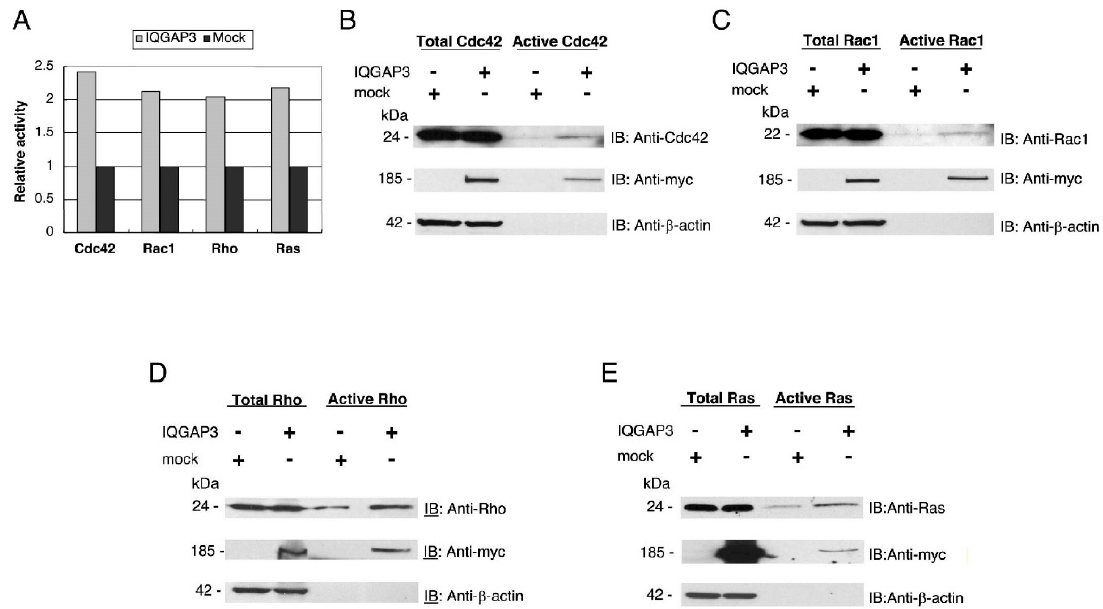
Figure 6. Induction of active Cdc42, Rac1, Rho and Ras GTPases by IQGAP3. ( A ) The relative amount of active small GTPases in 293T-IQGAP3 cells (gray bars) compared to 293T-mock cells (black bars). Total and active forms of GTPases in the cells were quantitated by densitometry after immunoblot analyses. The relative fold changes in this bar graph represent the densitometry values from the representative blots shown in Figure 6B–E. ( B ) Induction of active Cdc42 by IQGAP3, and association of active Cdc42 with myc-tagged IQGAP3. The total amount of Cdc42 (active + inactive) in the input and active Cdc42 precipitated with GST-Pak1 was analyzed by immunoblot analysis using anti-Cdc42 antibody (upper panel). Interaction between active Cdc42 and myc-tagged IQGAP3 was analyzed by immunoblotting with anti-myc antibody (middle panel). The expression of β -actin served as a quantitative control (lower panel). ( C ) Induction of active Rac1 by IQGAP3, and association of active Rac1 with myc-tagged IQGAP3. The total amount of Rac1 and active form of Rac1 were analyzed by immunoblotting with anti-Rac1 antibody. ( D ) Induction of active Rho by IQGAP3, and association of active Rho with myc-tagged IQGAP3. The total amount of Rho and active form of Rho were analyzed by immunoblotting with anti-Rho antibody. ( E ) Induction of active Ras by IQGAP3, and association of active Ras with myc-tagged IQGAP3. The total amount of Ras and active form of Ras was analyzed by immunoblotting with anti-Ras antibody.